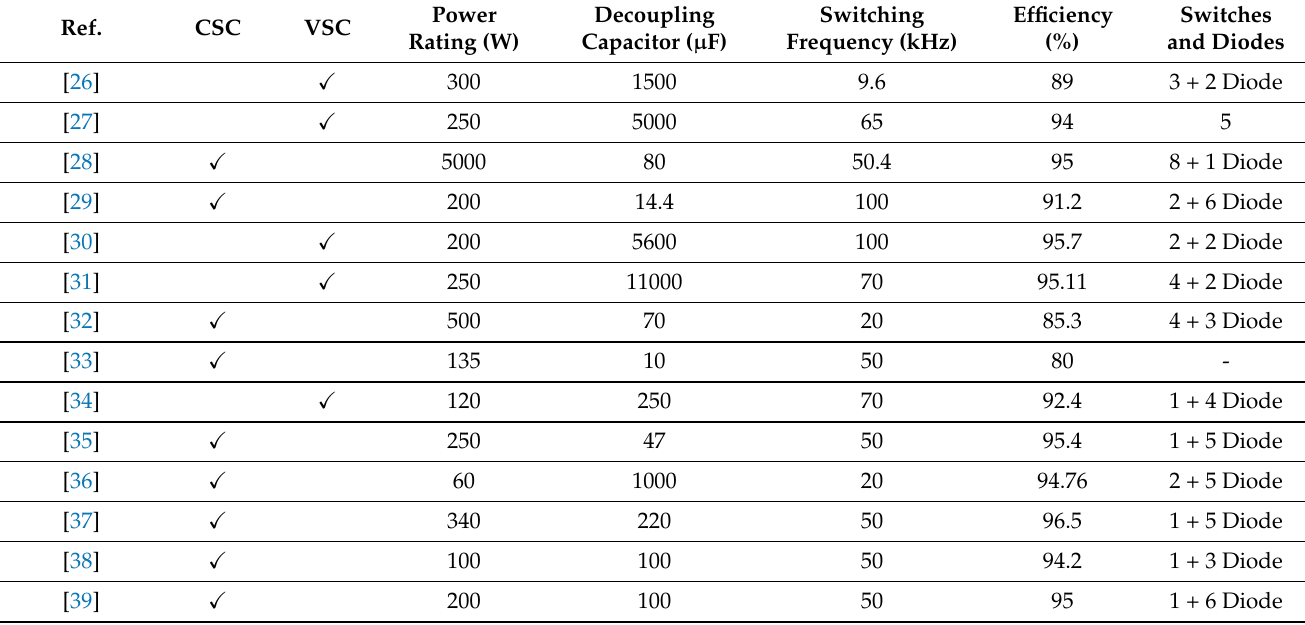
Table 2. Characteristics of DC-DC PWM